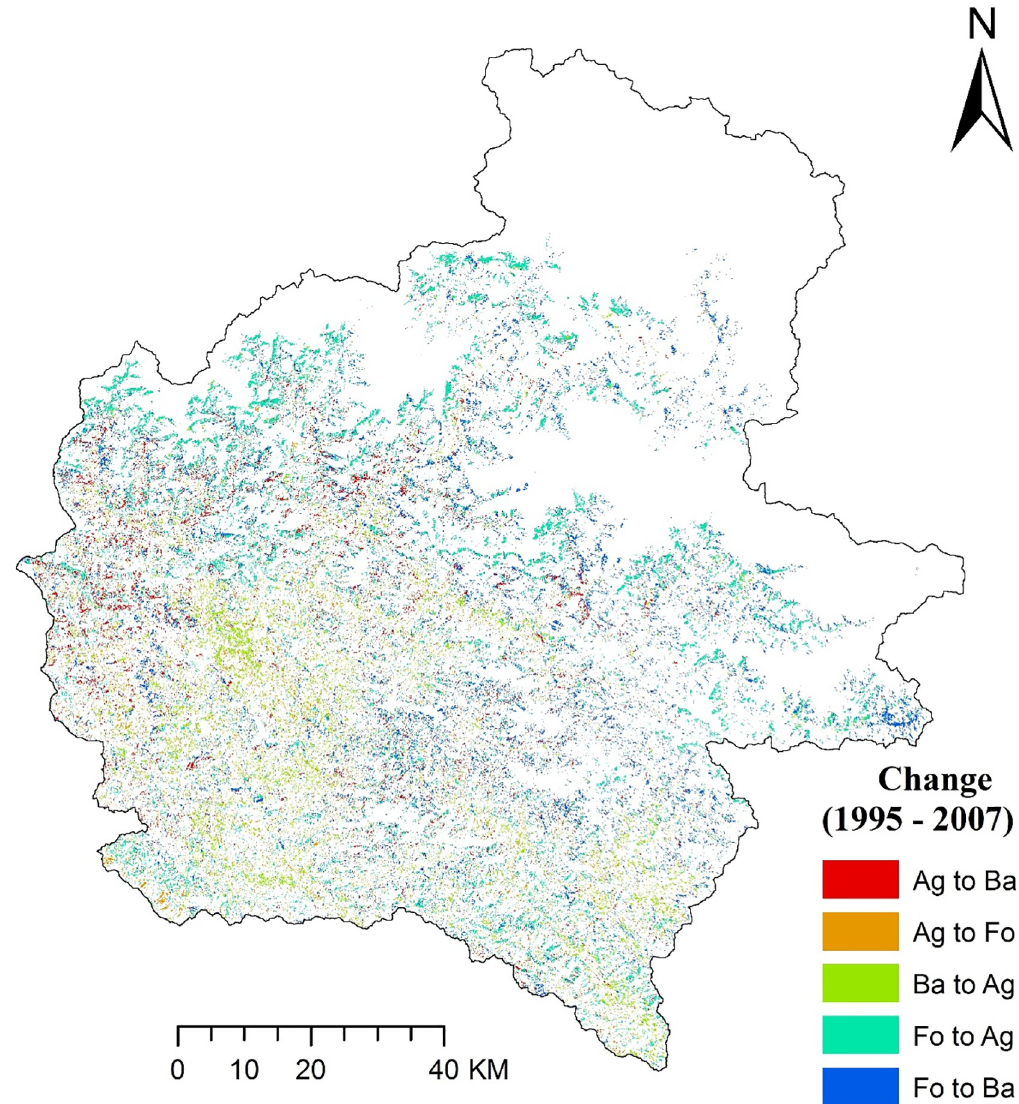
Fig 4. Change analysis thematic map showing land use conversion from 1995 to 2007 (Ag = Agriculture, Ba = Barren land, Fo = Forest). was the highest in the Siwalik Hills, ranging from 8.77 to 9.84 t/ha/year, and the lowest in the High Himalayas (0.07 to 1.10 t/ha/year). Presence of erodible silt particles and occurrence of steep slopes have made the Siwalik Hills the most eroded zone across the study area. The sec- ond most eroded zone was the Middle Mountains followed by the High Mountains, Terai Plains and High Himalayas. Gently sloping flatlands in Terai Plains [52] and presence of snow cover in the High Himalayas make these physiographic regions less susceptible to soil erosion. Agriculture was the most eroded land use in the study area. Lack of vegetation cover is the main reason for higher soil losses in the agricultural lands [53]. Erosion rates through agricul- tural fields had reduced through the years, but with the upsurge in agricultural lands, the con- tribution of agriculture to gross soil erosion ultimately increased. Surprisingly, bare lands lost